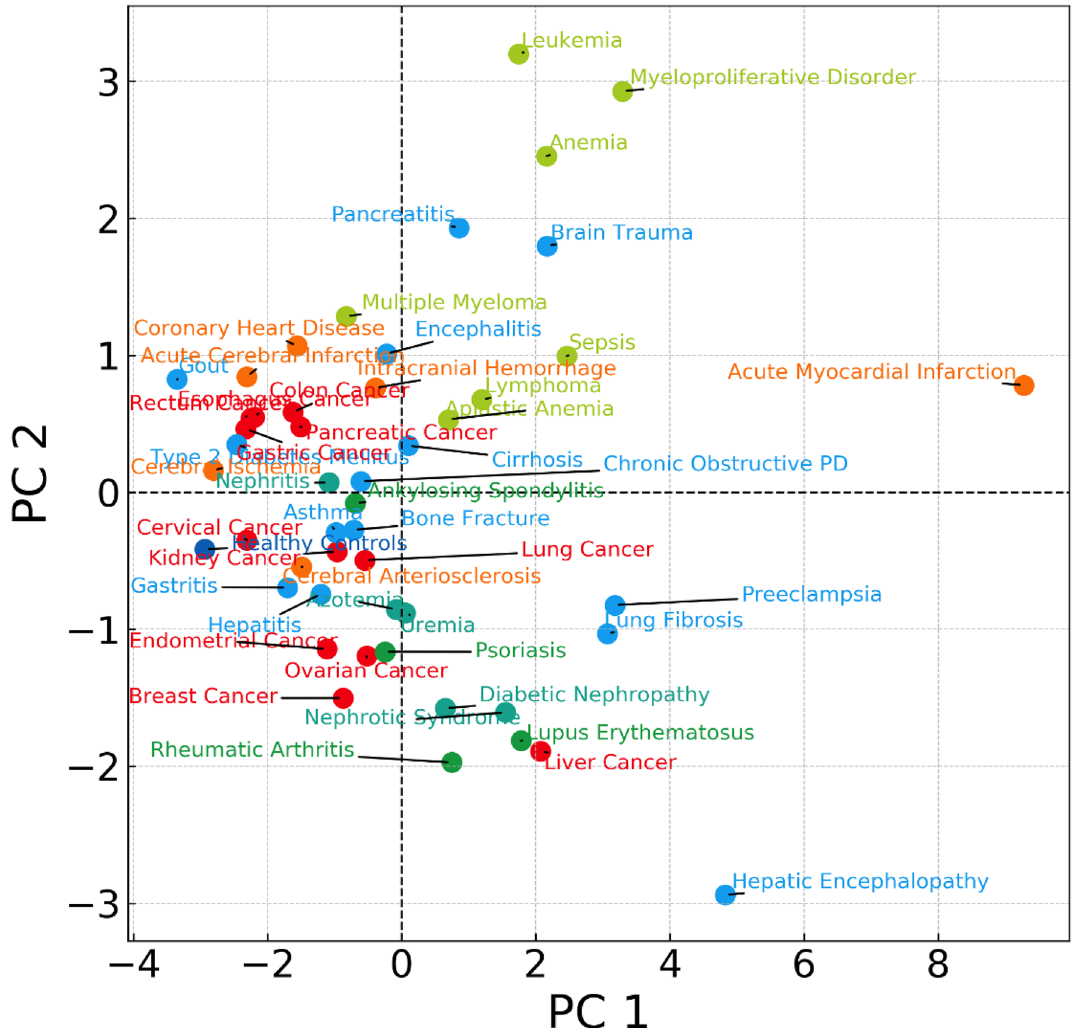
Figure 2. The changes in serum LDH activitie had common features for the same class of diseases. PC means Principal Component. The 48 diseases were divided into six major classes, including solid cancers (marked in red), autoimmune diseases (marked in green), cardiovascular and cerebrovascular diseases (marked in orange), acute diseases (marked in blue), blood-related diseases (marked in yellowish-green), and kidney diseases (bluish-green). The statistics features of the LDH activities for each of 48 diseases, including the mean, standard deviation, min/max value, 25, 50, and 75 percentiles were quantified. The obtained statistics features were further decoupled into two major components and